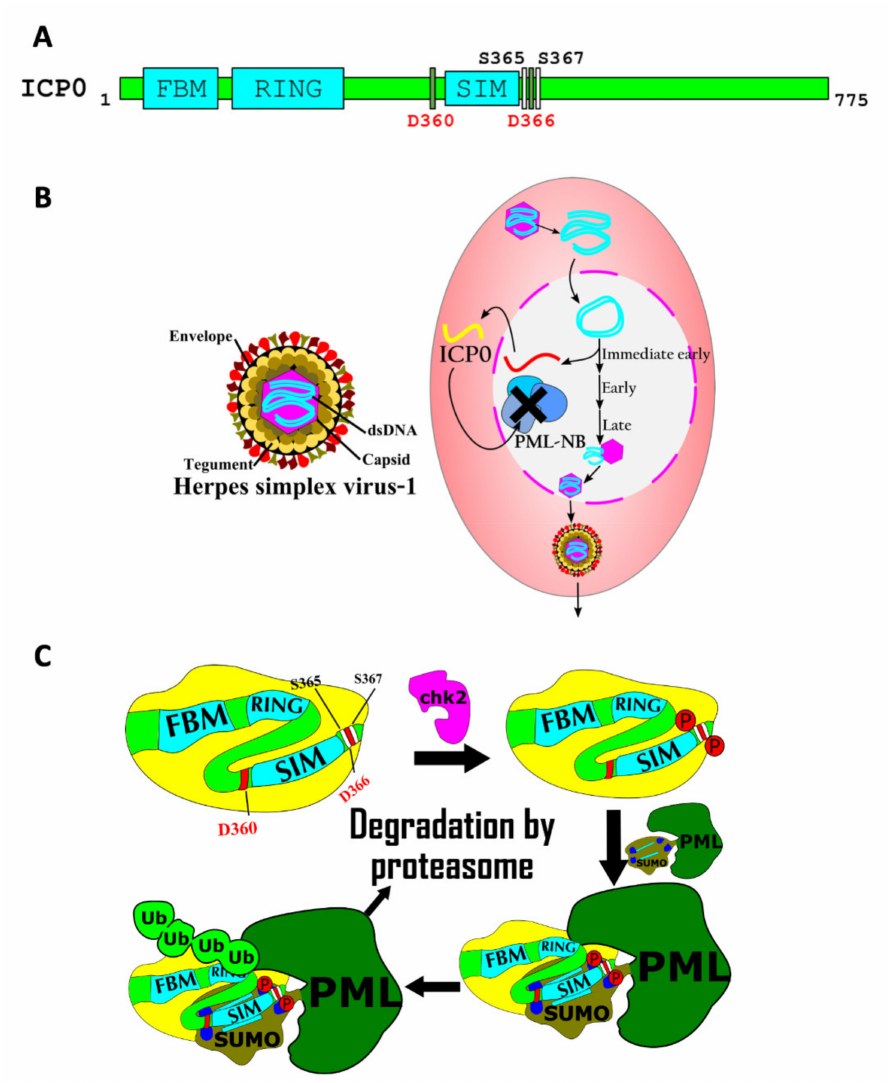
Figure 4. A role for a SIM in the viral ICP0 protein in HSV-1 host–pathogen interaction. ( A ) The primary structure of Herpes simplex virus 1 ICP0 protein, a SUMO-targeted ubiquitin ligase. The FHA-binding motif (FBM), the RING finger ubiquitin ligase domain (RING), and the SUMO